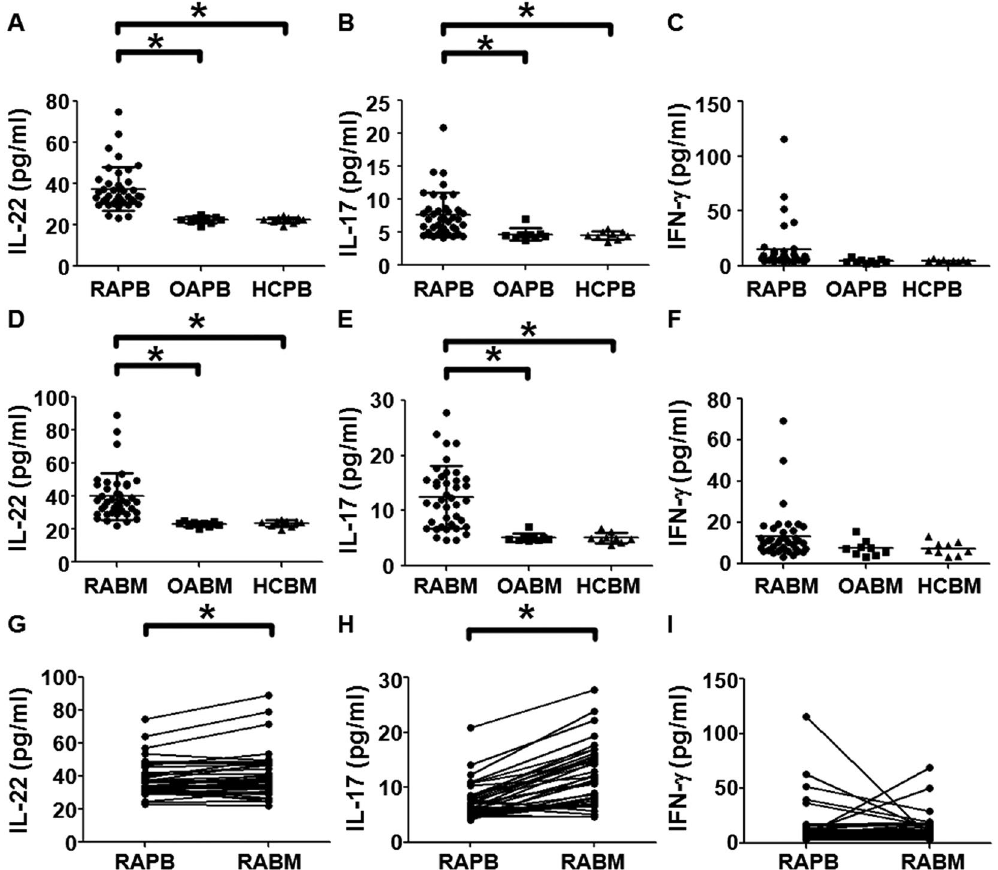
Figure 3. Concentrations of inflammatory cytokines related with T-helper cells. The concentrations of ( A ) IL-22, ( B ) IL-17 and ( C ) IFN- γ in peripheral blood from rheumatoid arthritis patients (RAPB), osteoarthritis patients(OAPB) and healthy controls (HCPB). The concentrations of ( D ) IL-22, ( E ) IL-17 and ( F ) IFN- γ in bone marrow blood from rheumatoid arthritis patients (RAPB), osteoarthritis patients(OAPB) and healthy controls (HCPB). The concentrations of ( G ) IL-22, ( H ) IL-17 and ( I ) IFN- γ in peripheral blood and bone marrow blood from rheumatoid arthritis